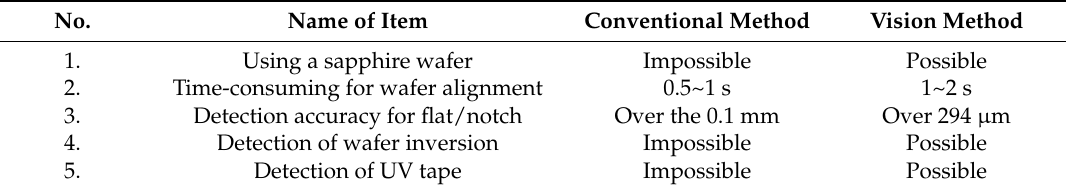
Table 1. The inspection result with comparison of conventional and proposed methods.